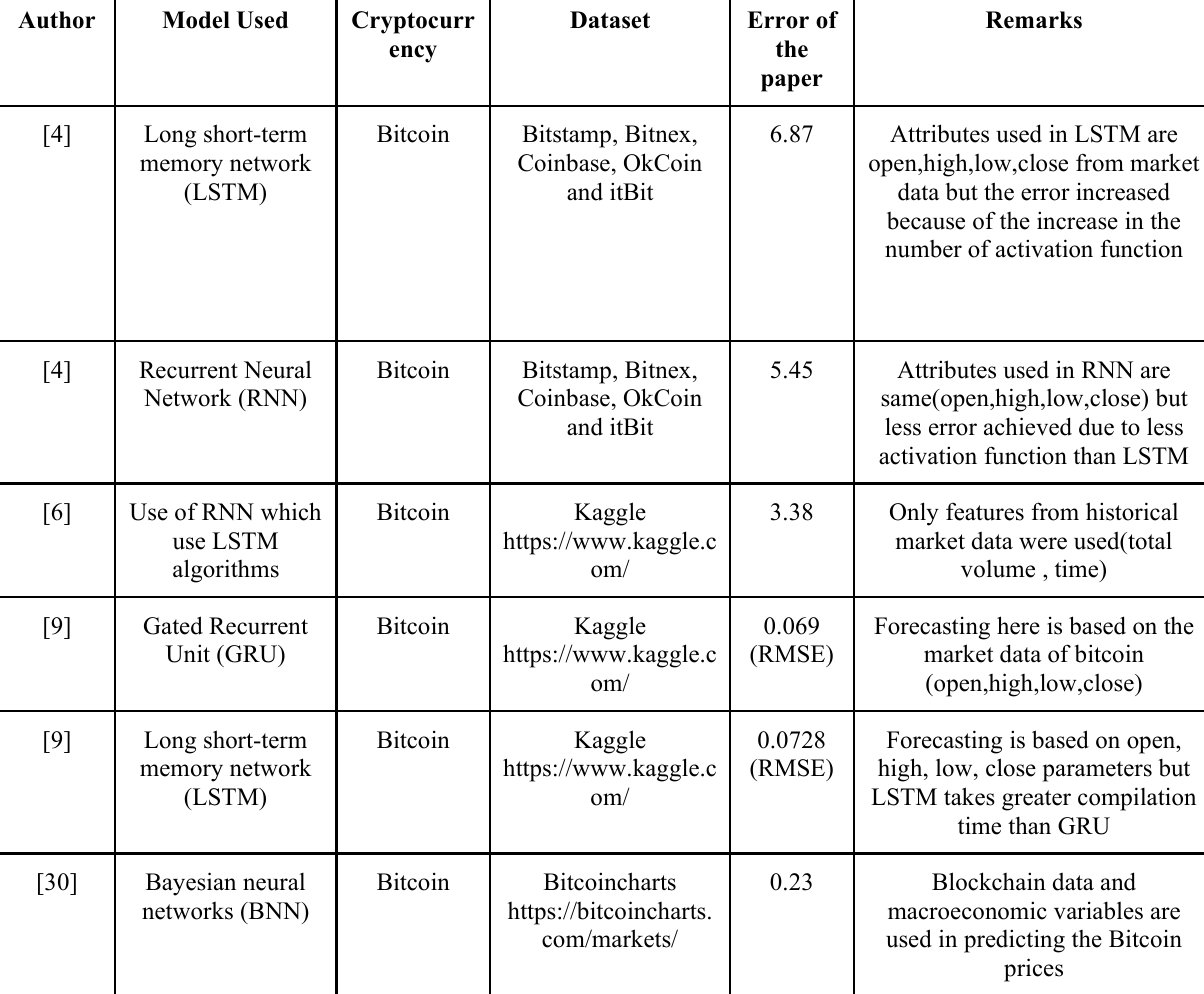
Table 1. Comparison of existing